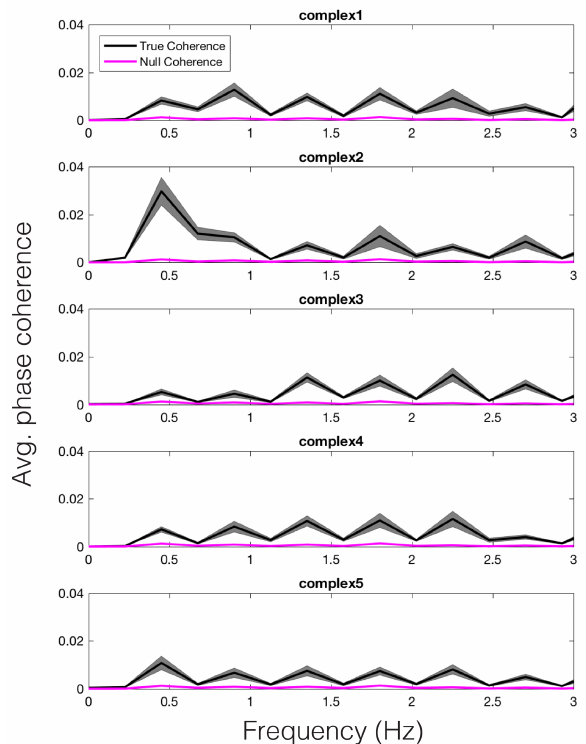
Figure 7. Average phase coherence across participants between the pupil and peak reson filter model, for each stimulus (black). Average null coherence is plotted in magenta. The width of each trace represents standard error of the